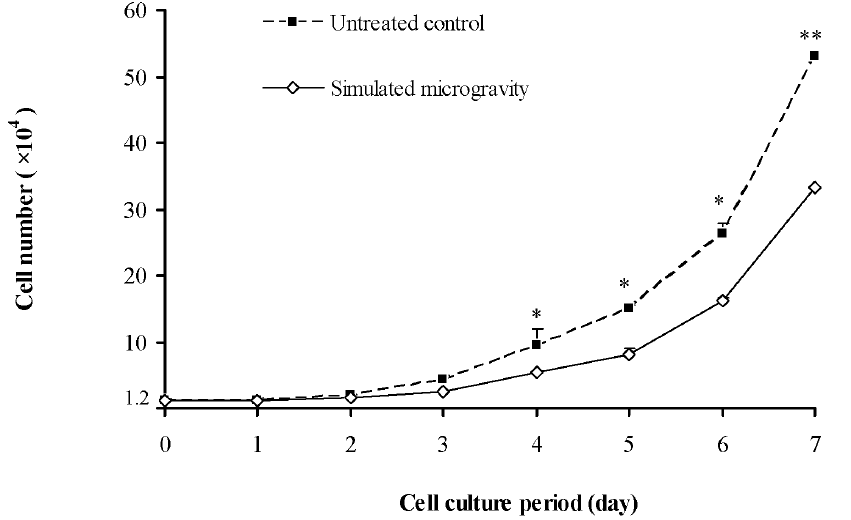
Figure 1. Cell growth curves of MG-63 under simulated microgravity. Numbers of living cells are counted in the following 1 , 7 days. Cells grow into logarithmic phase before the 4th day on and simulated microgravity has its inhibition effect to cell proliferation with the extension of treatment time. After being treated for 4–7 days, the cell number of untreated control and simulated microgravity exhibit significant differences. The data shown represent the mean 6 S.E. (n=3). *0.01 , P , 0.05, and ** P , 0.01 (t-test as compared to untreated control group).